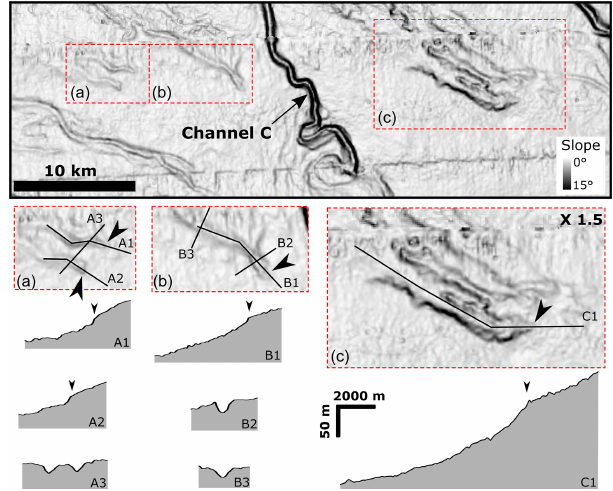
Figure 8. Close-up view of the gradient-shaded map showing ero- sional lineations (a and b) and amalgamated scours (c) in the central part of the system (location in Fig.